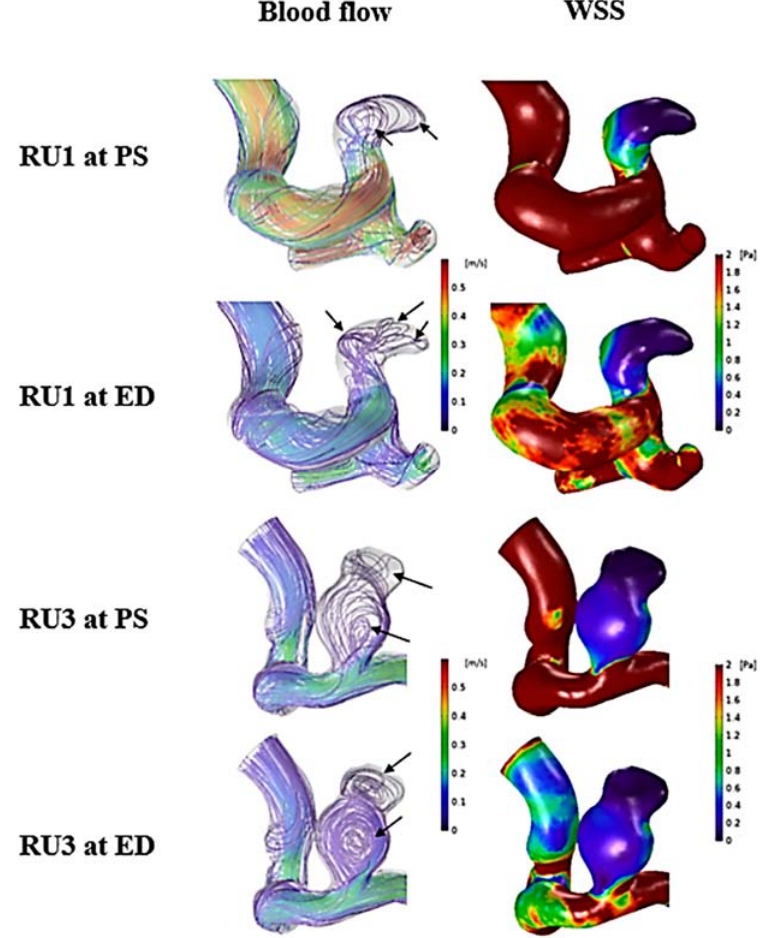
Figure 6. Two representative cases (RU1 and RU3) of ruptured aneurysms at peak ‐ systole and end ‐ diastole. The streamlines showing the flow stability of the ruptured aneurysm (blood flow column). The black arrow indicates the recirculation region of the aneurysm. The distribution of wall shear stress on the aneurysms showing low wall ‐ shear stress area (WSS column). PS: peak ‐ systole; ED: end ‐ diastole; RU: ruptured aneurysm; WSS: wall shear stress.